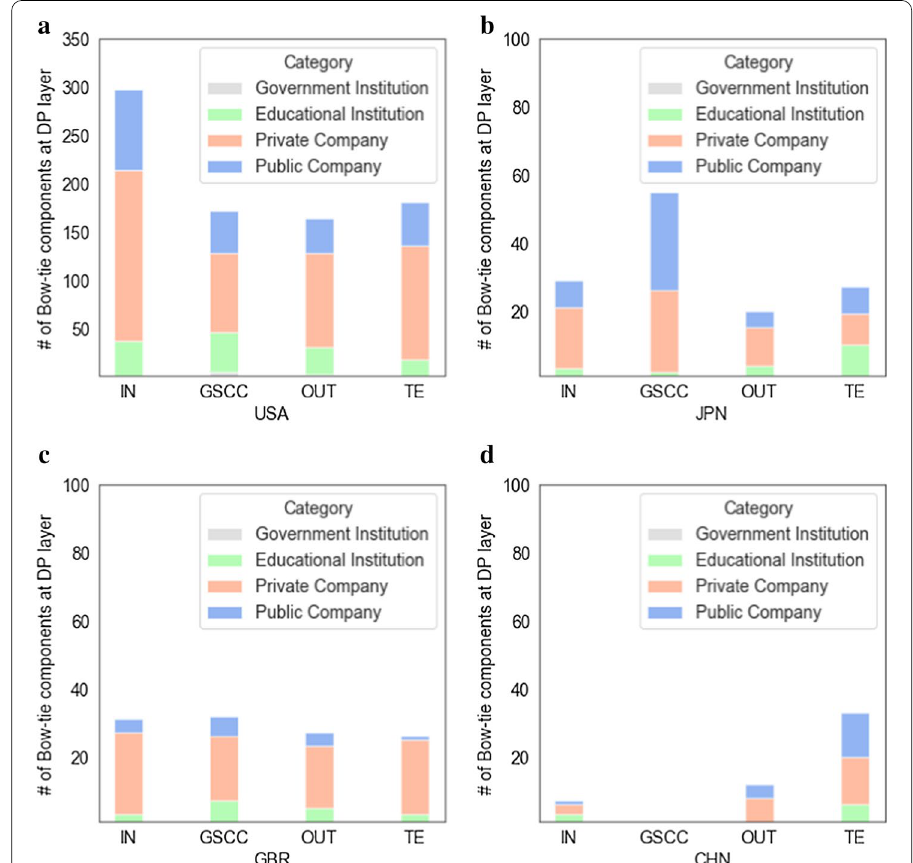
Fig. 8 The number of bow tie components in the drug pipeline network by countries. We categorized each component using the types of business entities and only showed the top four countries located in the GWCC, namely, a US, b JPN, c GBR, and d